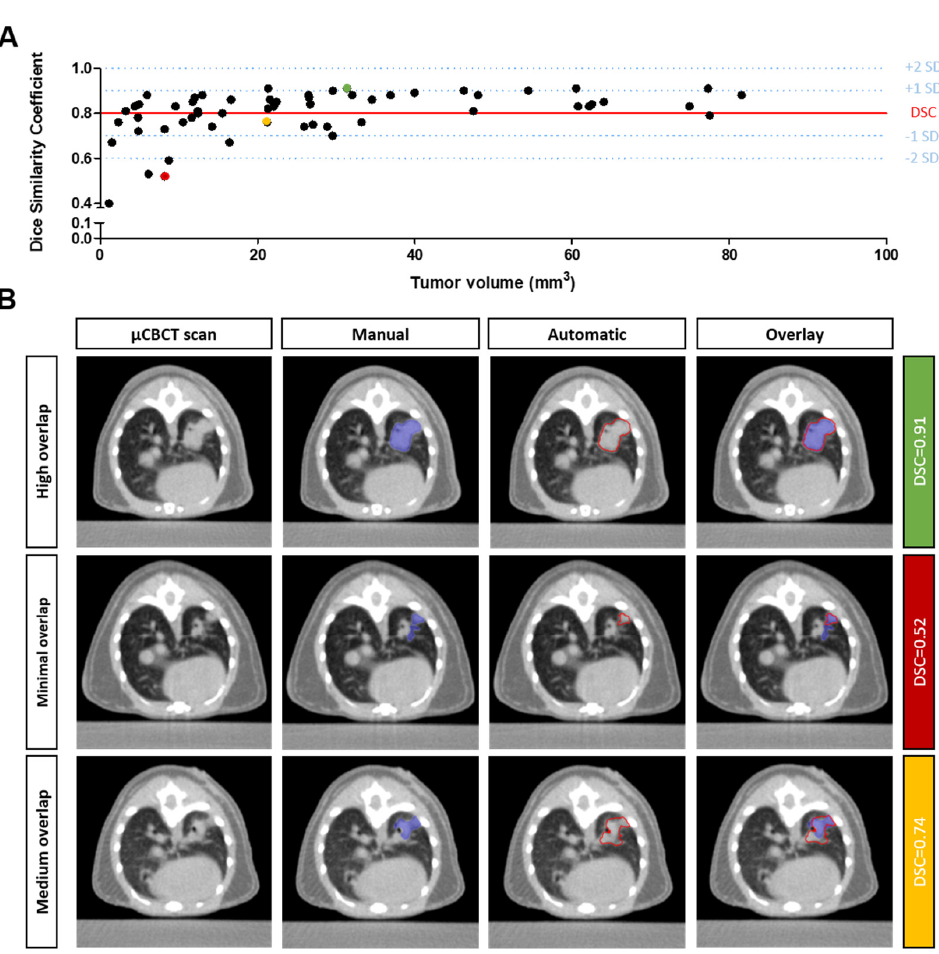
Figure 2. Qualitative evaluation of the algorithm performance. ( A ) Scatterplot of the DSC versus tumor volume ( n = 60). The mean DSC is indicated with a horizontal red line. The ±1SD and ±2SD are indicated with blue dotted lines. ( B ) Axial µCBCT images showing (from left to the right) an unsegmented scan, the manual tumor segmentation, the automatic tumor segmentation, and the overlay of the manual and automatic segmentations. The first row shows an illustrative case with a high overlap, the second row shows a case with minimal overlap, and the third row depicts a case with medium overlap. The corresponding DSCs of each row in ( B ) are indicated in the scatterplot of ( A ) by the green, red and yellow markers.